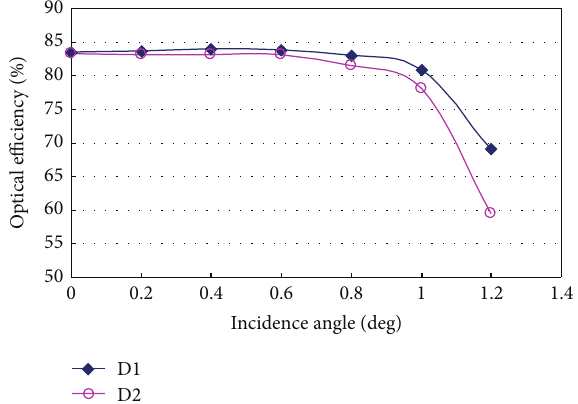
Figure 12: Irradiance distribution of the two-reflector solar concen- trator with optimal SOE D1 of Phase II (normal